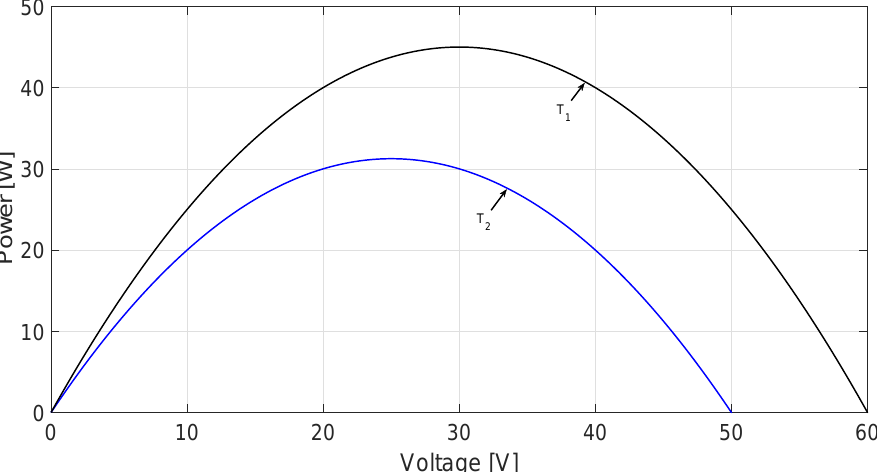
Figure 13. P-V characteristics of the proposed PV emulator to represent various temperature conditions. The behavior of the Matlab/Simulink PV emulator under non-uniform